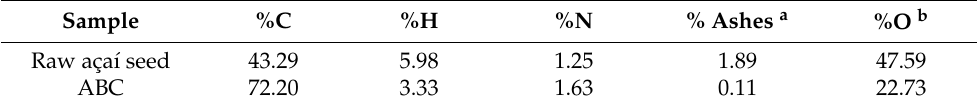
Table 2. Elemental analysis of ABC carbon and raw aça í